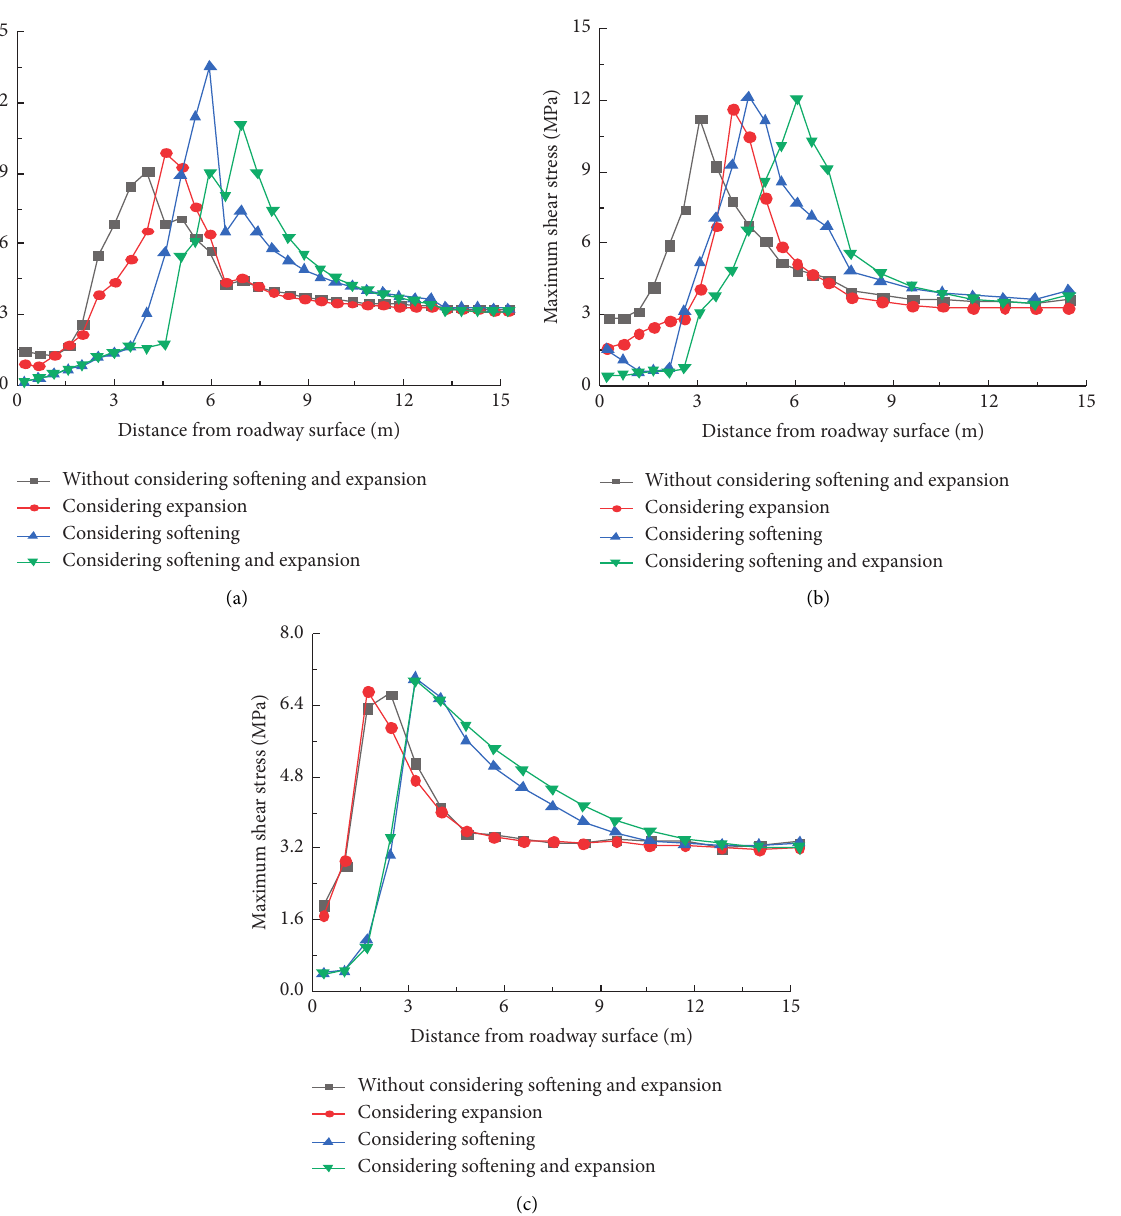
Figure 6: Maximum shear stress distribution curves of weakly cemented soft rock in the roadway under different simulation schemes. (a) Roof. (b) Floor. (c) Two